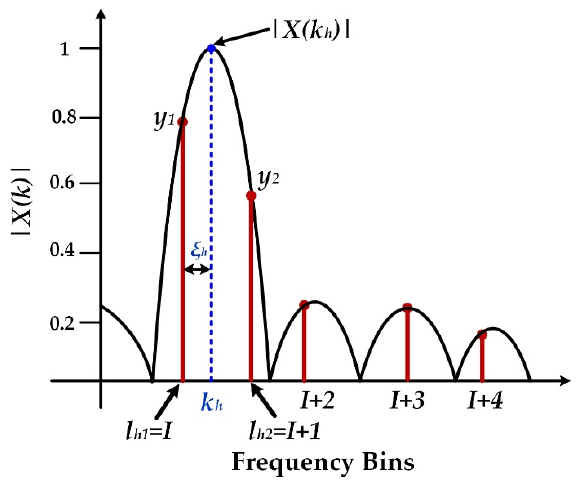
Figure 2. Computation process of the EDSLIFFT algorithm using 4MSCW.